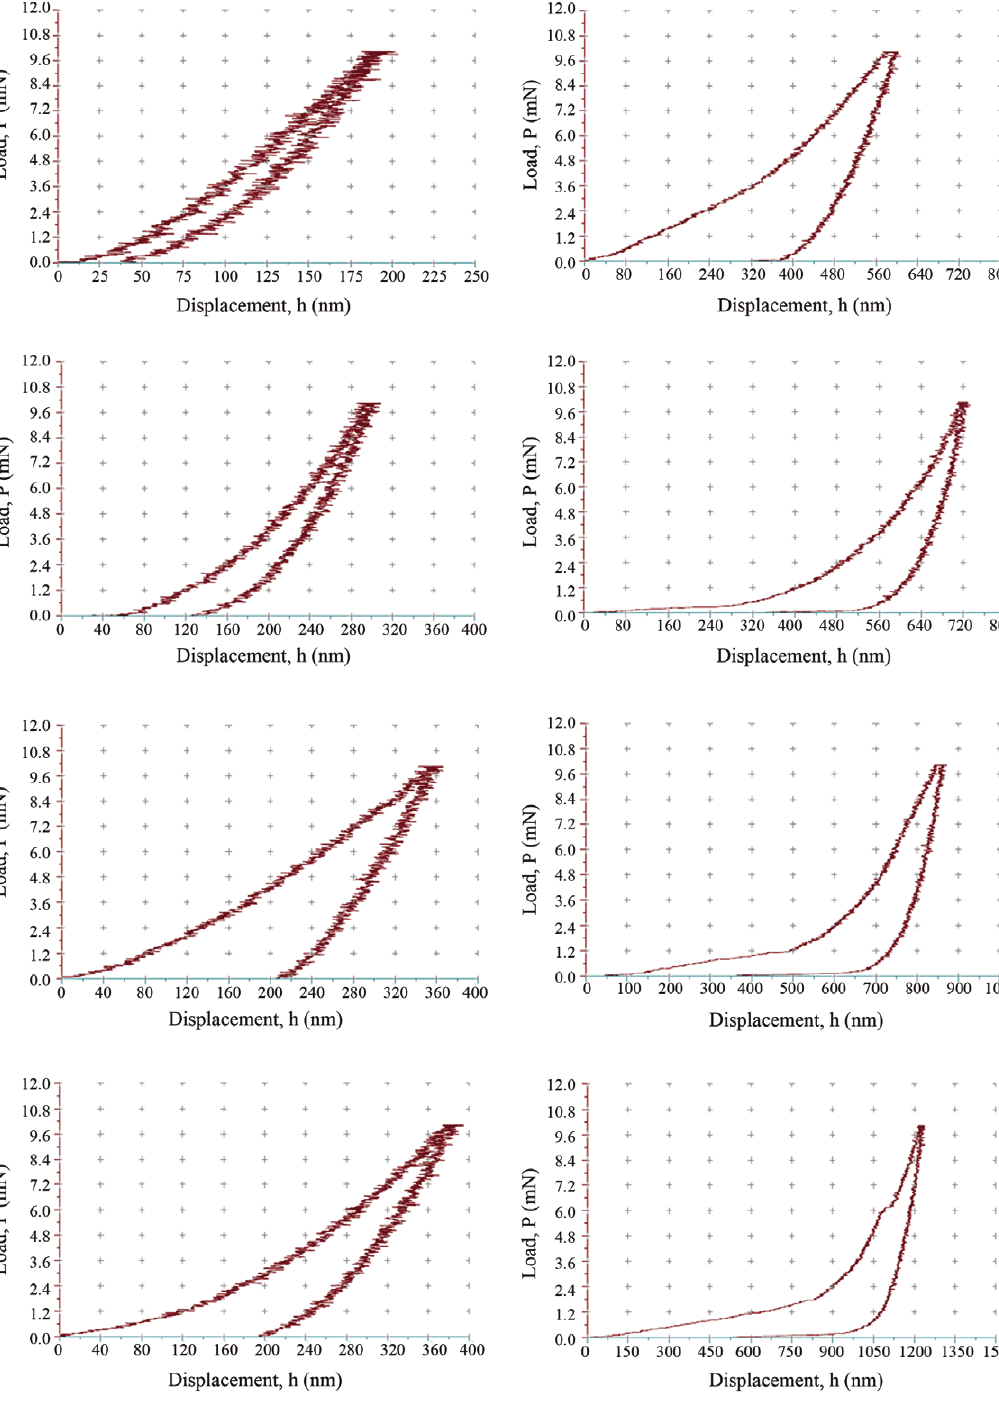
Figure 4 Representative load-displacement (P-h) curves of dental porcelain